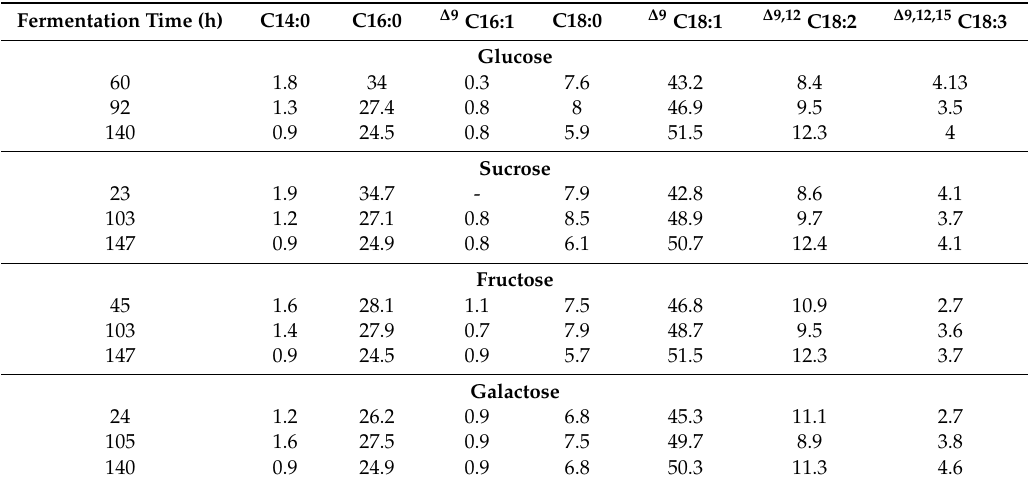
Table 3. Fatty acid composition of lipids produced during shake flask cultures of R. toruloides on commercial sugars (glucose, sucrose, fructose,